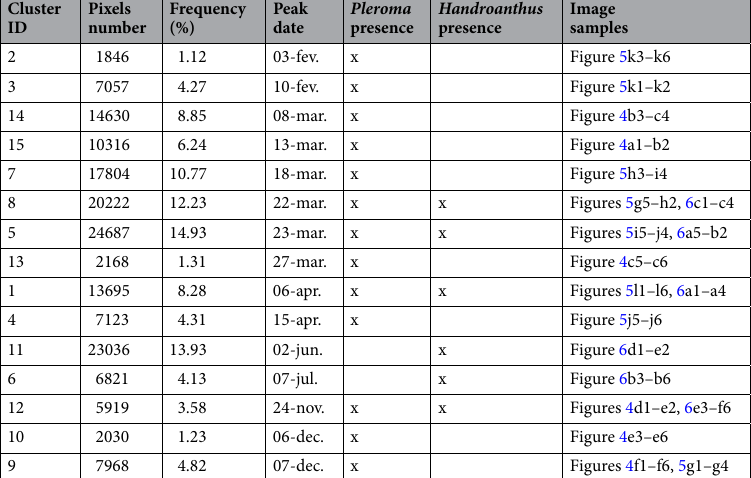
Table 1. Characteristics of the groups obtained by K-means clustering, using flowering dates and coordinates, and sorted by flowering peak date: ID number of the group, number and frequency (%) of pixels, date of the flowering peak, identification of the genus detected in the cluster ( Pleroma and/or Handroanthus ) and sample of image subsets for each cluster. Note that a pixel can belong to two clusters if it has two flowering